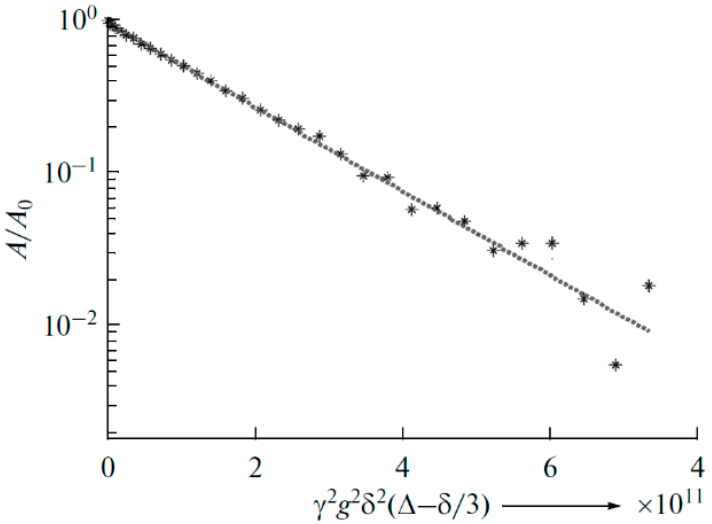
Figure 30. Diffusion decay of 7 Li for polymer electrolyte no. 3 with Li 2 TiO 3 nanoparticles (10 wt %) [92].